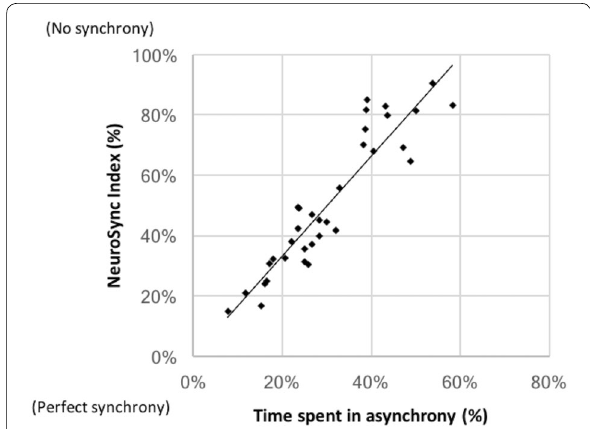
Fig. 4 Relationship between the asynchrony results obtained using the two methods: the automatic NeuroSync index and the percent‑ age of time spent in asynchrony derived from the manual breath‑by‑ breath